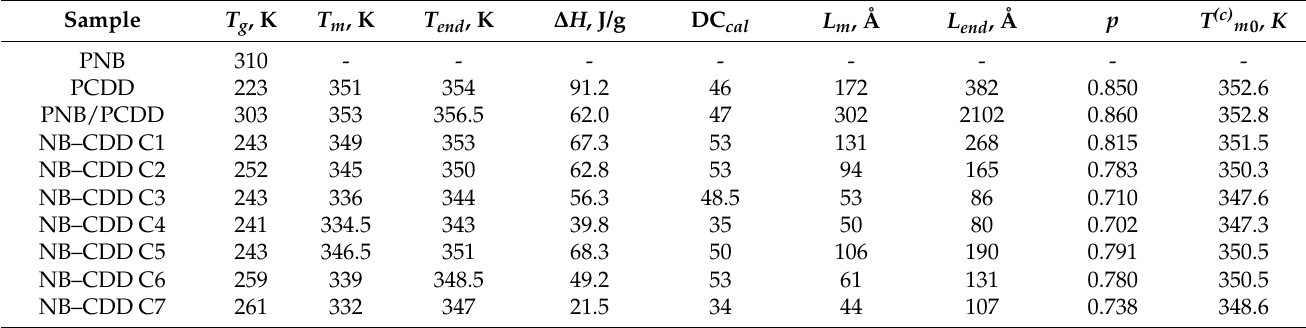
Figure 4. Second-heat DSC thermograms of PCDD, PCDD/PNB blend, and NB–CDD C1–C7 copolymers. Table 3. Thermal characteristics of the studied